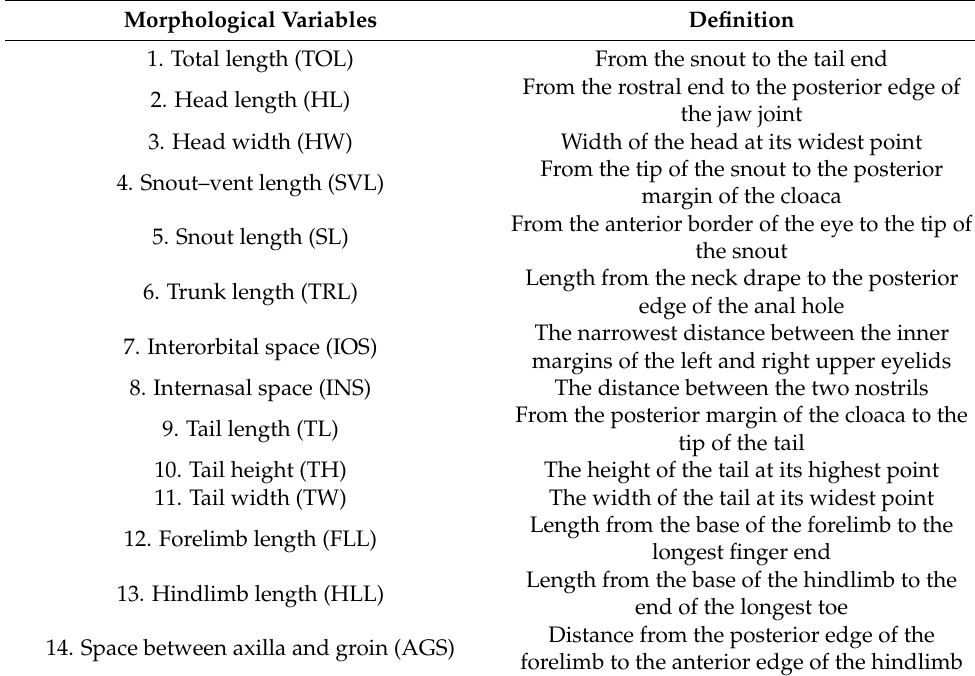
Table 1. Morphological variables assessed in this study and their abbreviations. Morphological Variables